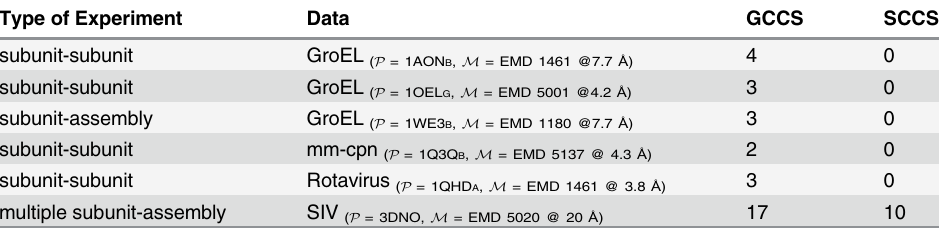
Table 2. Results of applying PF 2 fit — SE(3) on a selection of datasets from the cryoEM modeling chal- lenge (Experiment 3) using both the GCCS and SCCS. An error measure similar to ETR is provided as the number of residues excluded outside a given iso-contoured molecular surface. The SCCS yielded on average results that exclude 2 – 4 fewer residues than the GCCS. Type of